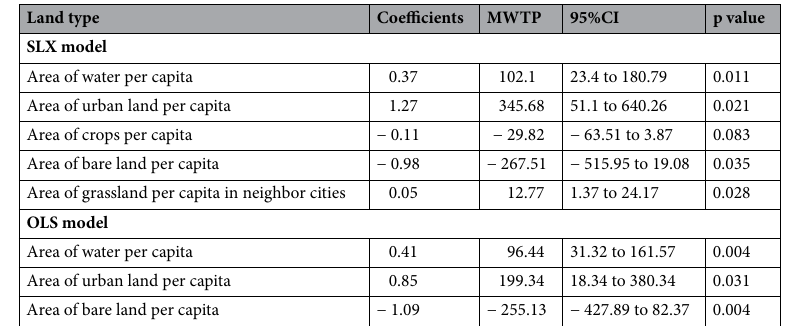
Table 2. MWTP of land cover. The land cover variables without significant coefficients are not shown. Exchange rate in 2016 from World Bank is used, where 1 United States Dollars (USD) is roughly equal to 103.45 Japanese Yen: https:// data. world bank. org/ indic ator/ PA. NUS. PPP. Unit of MWTP: USD Capita m 2